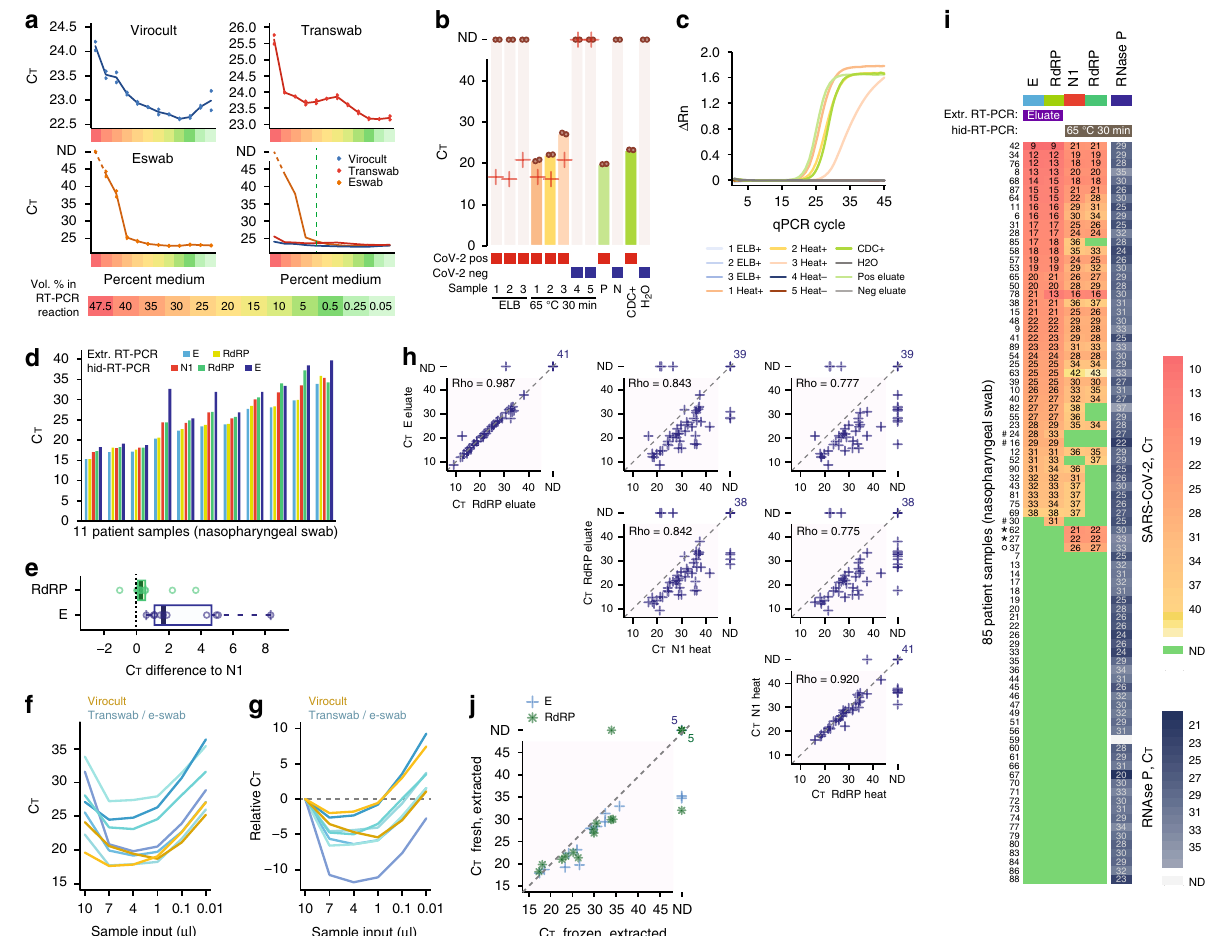
Fig. 2 SARS-CoV-2 hid-RT-PCR on frozen nasopharyngeal swab samples. a C T values from RT-qPCR performed on dilution series of transport medium (Virocult, Transwab, and Eswab) using 50,000 spiked copies of synthetic full-genome SARS-CoV-2 RNA and the N1 primer-probe set. Lines represent the mean of duplicates, shown individually as dots. ND: not detected. b Bar plots of C T from SARS-CoV-2 hid-RT-PCR on clinical nasopharyngeal swabs inactivated with MagNA Pure 96 External Lysis Buffer (ELB) or heat (65 °C 30 min). Dots indicate C T of hid-RT-PCR duplicates and crosses indicate C T values from diagnostics performed on fresh extracted RNA. Positive controls were extracted RNA from a positive sample (P) and a CDC positive control DNA plasmid (CDC + ). Negative controls were extracted RNA from a negative sample (N) and water (H 2 O). ND: not detected. c Ampli fi cation plots showing normalized reporter value ( Δ Rn, linear scale) as a function of qPCR cycle for the experiment and samples described in ( b ). ( d ) Bar plots of C T values of 11 positive nasopharyngeal swab samples using primer-probe sets targeting SARS-CoV-2 gene E, N, and RdRP. e Boxplots of C T difference in same samples as in (d) comparing E and RdRP with the N1 primer-probe-set. Center lines denote the median, hinges denote the interquartile range (IQR) and whiskers denote outlier points at maximum 1.5 × IQR. f , g Line charts of C T from individual clinical samples (colored lines) using variable amount of sample input. Shown as absolute C T ( f ) or C T relative to the 10 μ l input (g). h Scatter plots of C T values from clinical diagnostics performed on extracted RNA ( y - axis) and hid-RT-PCR ( x -axis) of 85 nasopharyngeal swab samples, shown for different primer-probe set comparisons. Rho indicates Spearman correlation of positive samples. ND: not detected. i Heatmap of C T values from diagnostics performed on 85 clinical samples using extracted RNA (E, RdRP) and hid- RT-PCR (N1, RdRP), ranked by E gene C T . Control for sample integrity by RT-PCR for RNase P in the same samples shown on the right. Two patients, marked with asterisk, were negative in extraction-based diagnostics but positive by hid-RT-PCR. The patients were later re-tested by extraction-based clinical diagnostics and con fi rmed to be SARS-CoV-2 positive. The patient marked with a ring was not re-tested. Three samples, marked with hash, were called COVID-19 positive by routine diagnostics but not by any primer-set in hid-RT-PCR. j Scatter plot of C T values from 19 matched fresh ( y -axis) and freeze-thawed ( x -axis) extracted samples, using the E gene (cross) and RdRP (star) primer-probe sets. ND: not detected. hid-RT-PCR shown in this fi gure was performed on previously diagnosed frozen